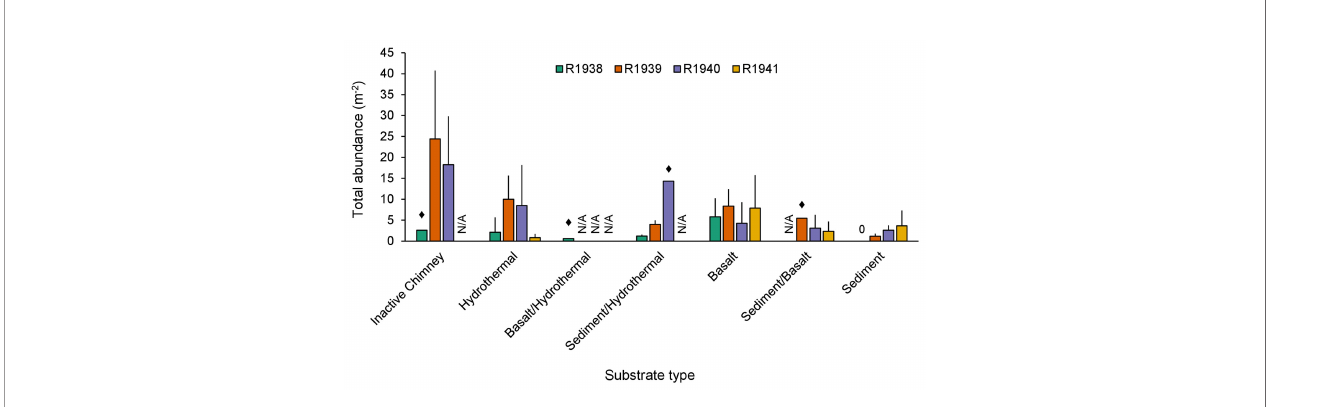
FIGURE 9 | Average total abundance (+SD) of all non-vent morphotaxa on each substrate type for dives R1938, R1939, R1940, and R1941 at the Endeavour segment of the Juan de Fuca Ridge. Abundances were averaged across image captures of the same substrate type. ♦ : n=1. “ N/A ” : indicates absence of that substrate type from the particular dive; 0 indicates true absence. “ Hydrothermal ” substrate refers to inactive substrate that is hydrothermally